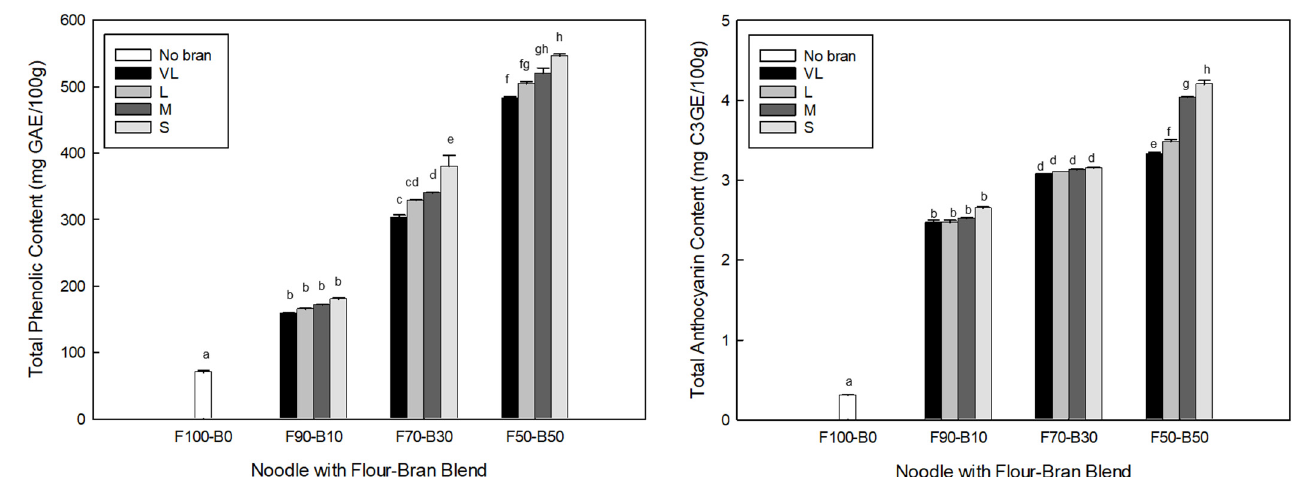
Figure 3. Total phenolic and anthocyanin content of fresh noodles made with flour-bran blends at different blending ratios and bran sizes. The different letters above the bars are significantly different ( p < 0.05) according to Tukey’s HSD test. VL, L, M, and S indicate the brans with very large, large, medium, and small particle